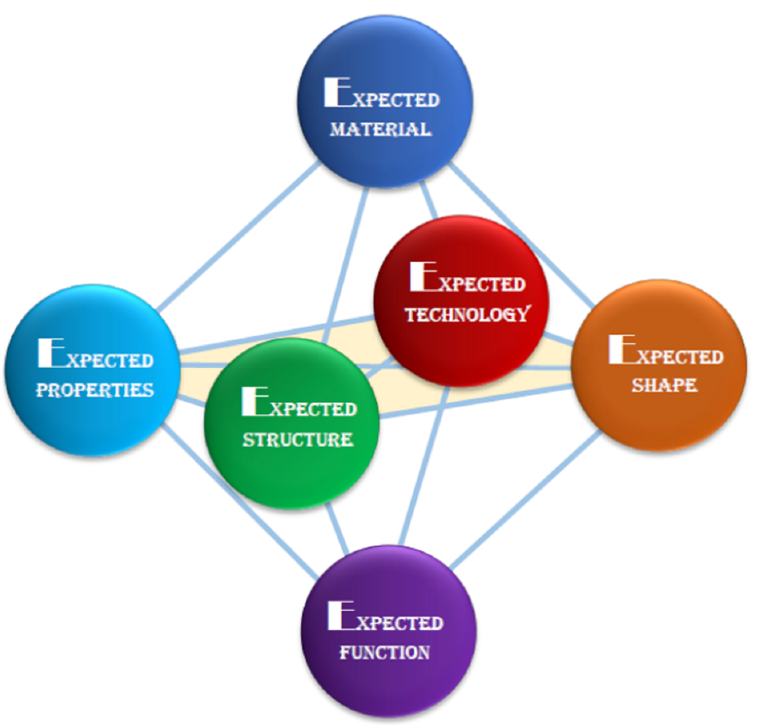
Figure 7. The 6xE principle of the six expectations, exposing the material science and material engineering paradigm.